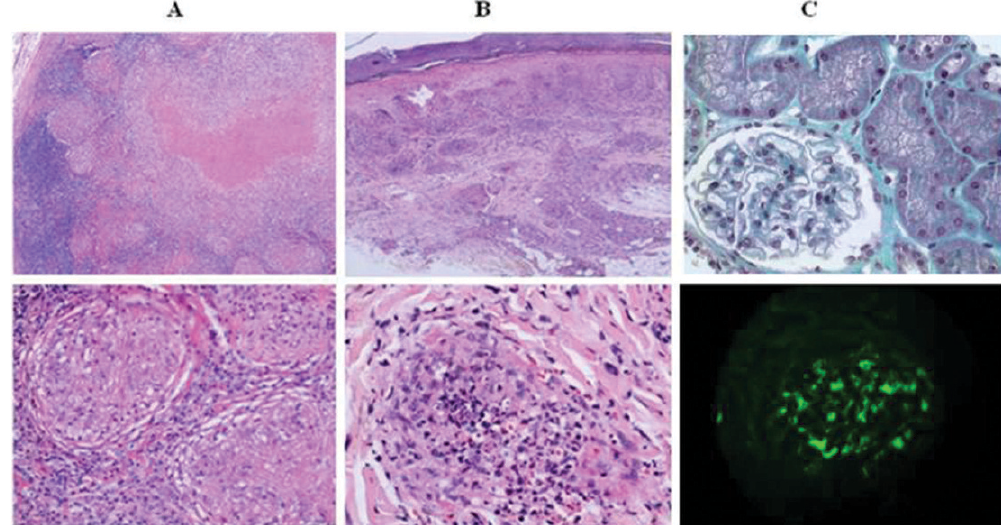
Figure 2 - Histopathology of lymph node (A), skin (B) and kidney (C) biopsies. A. Chronic granulomatous lymphadenitis with caseous necrosis without microorganisms (magnification: 20x and 40x) B. Leukocytoclastic and focal granulomatous vasculitis (objectives: 20x and 40x) C. Renal biopsy contained 13 glomeruli, 12 normal and one with a focal segmental lesion. DIF showed diffuse and global mesangial deposits of IgA (objective: 40x).